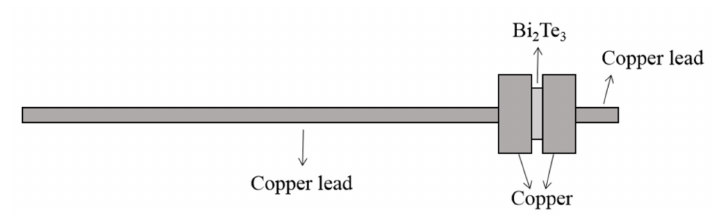
Figure 1. Schematic view of a PCL.